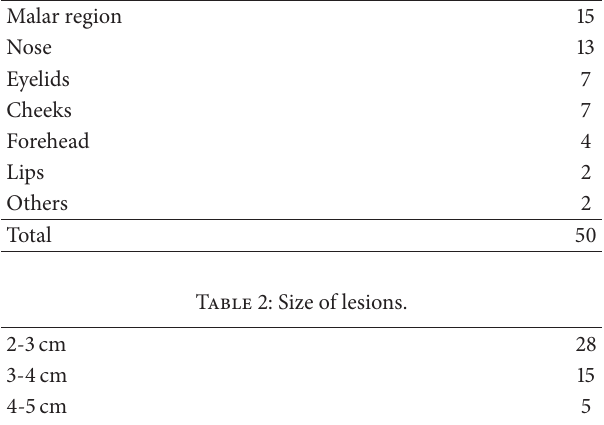
Table 1: Distribution of lesions on face.